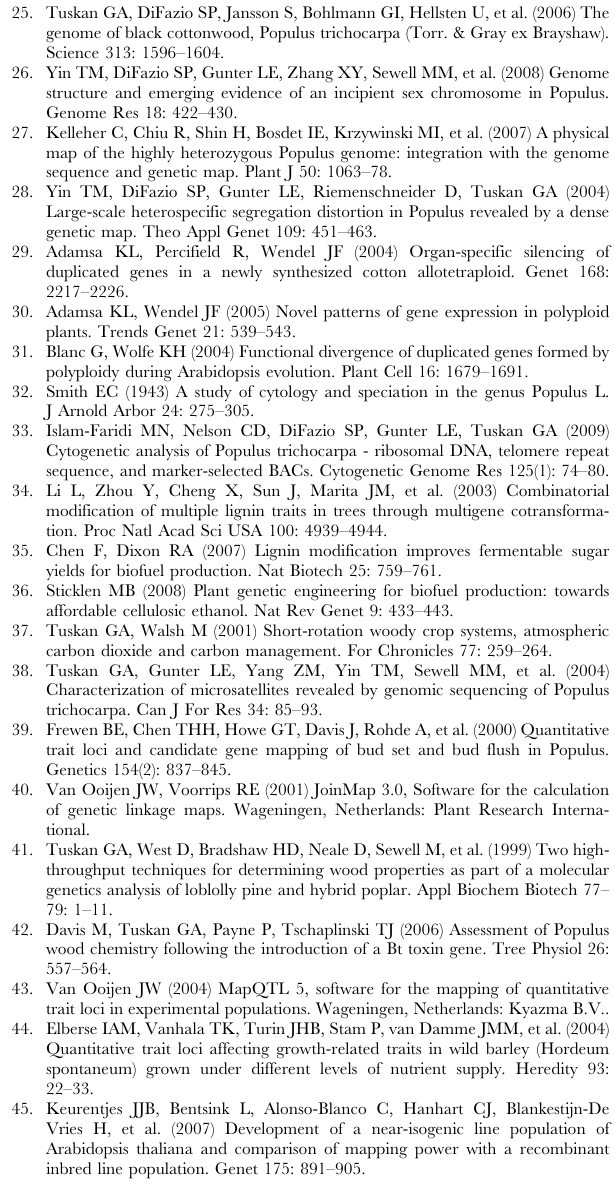
Table S1 Pair-wise correlation between all measured traits. Table S2 Distribution test for the phenotypic data and parameters associated with each trait before and after BOXCOX transformation.